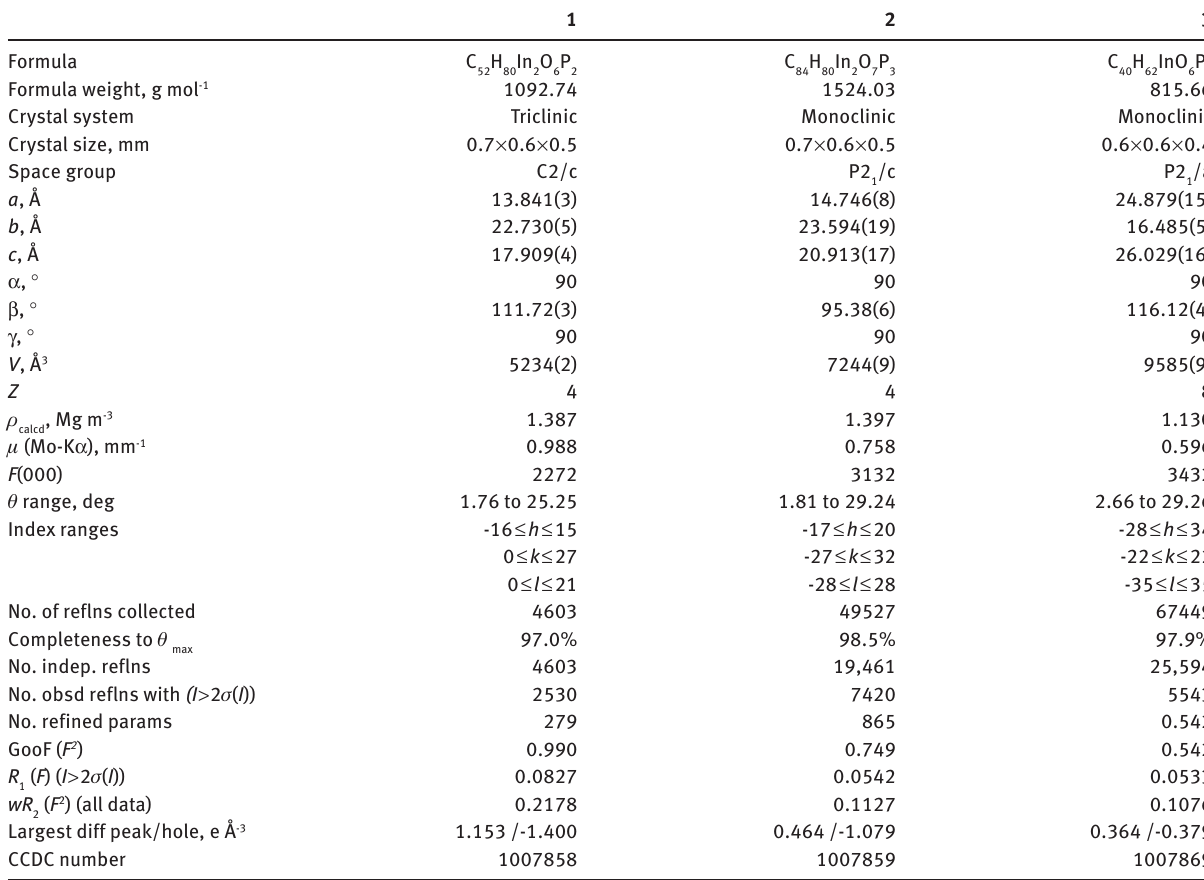
Table 1 Crystal data and structure refinement of 1 – 3